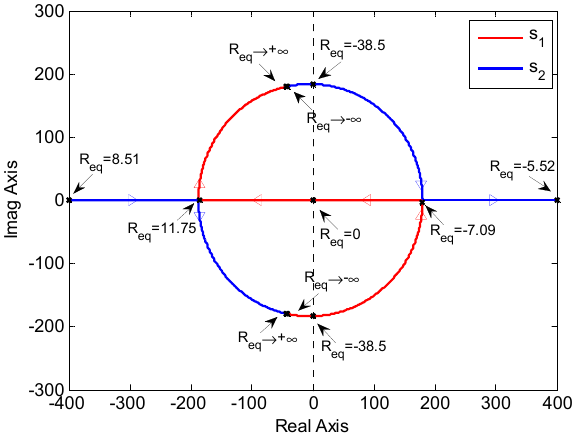
Figure 8. Root loci for variation of R EQ .